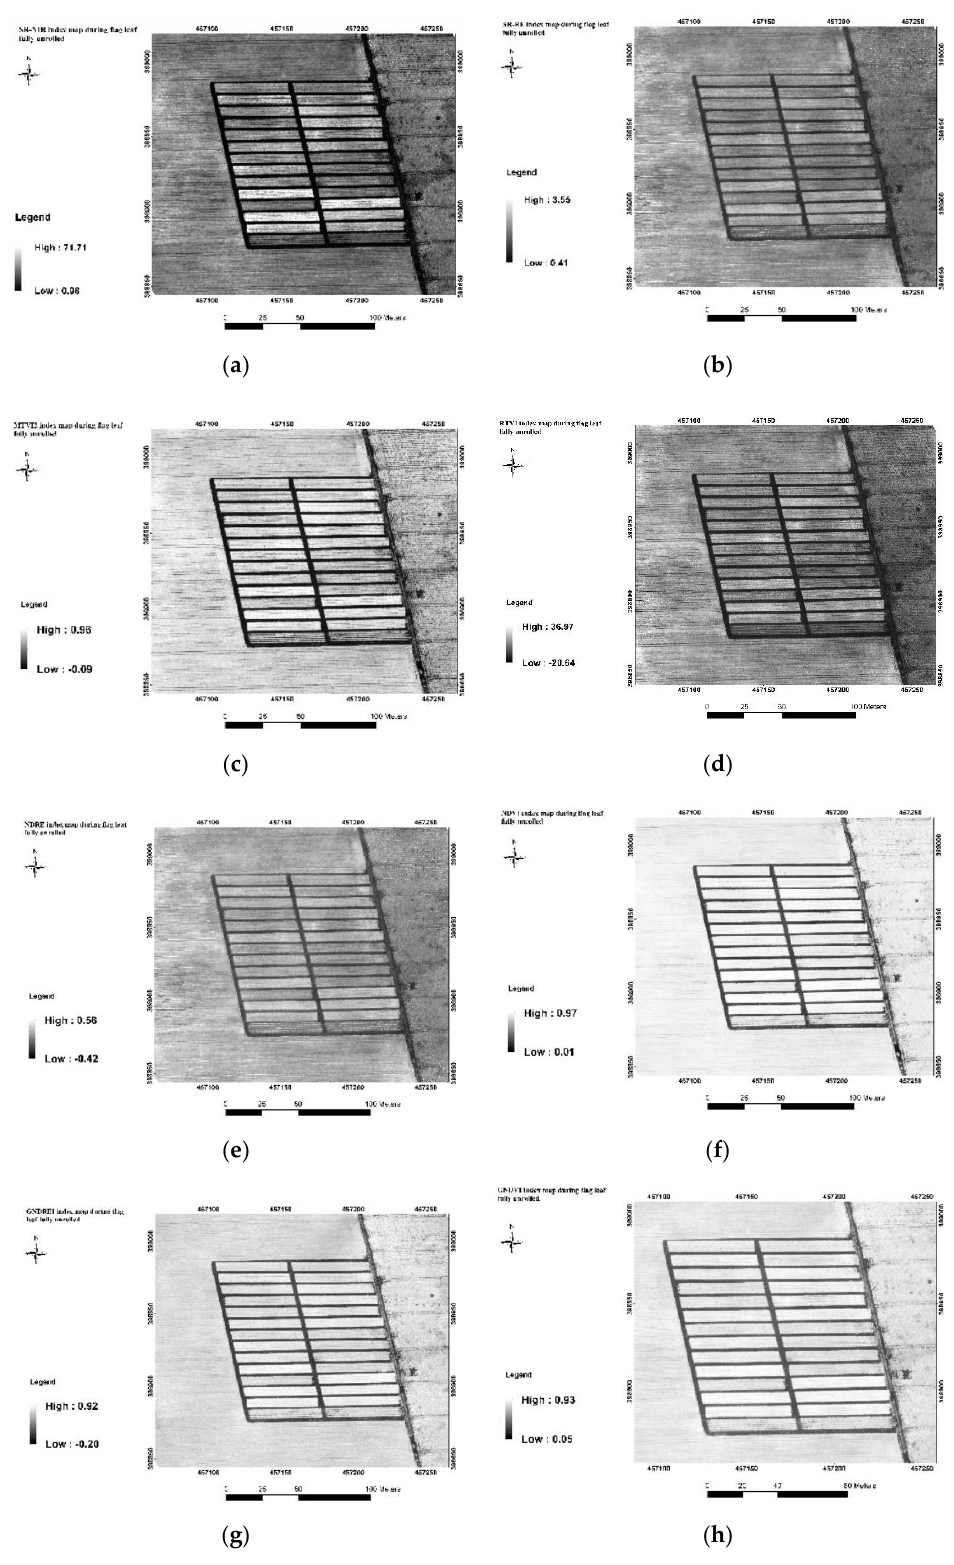
Figure 9. Vegetation index maps ( a ) SR-NIR; ( b ) SR-RE; ( c ) MTVI2; ( d ) RTVI; ( e ) NDRE; ( f ) NDVI; ( g ) GNDRE; ( h ) GNDVI during flag leaf fully unrolled stage before sampling.